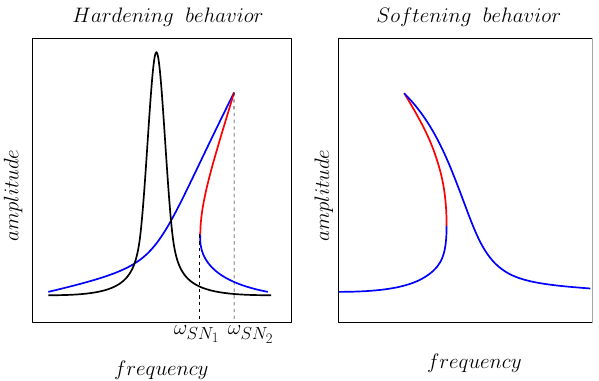
Figure 8. ( Left ) Typical amplitude response of a linear resonator (black) versus nonlinear resonator (blue–red) with an hardening spring. Blue and red lines correspond to amplitude of attractive (stable) and saddle (unstable) oscillations, respectively. ( Right ) Amplitude response of a nonlinear resonator with a softening spring.